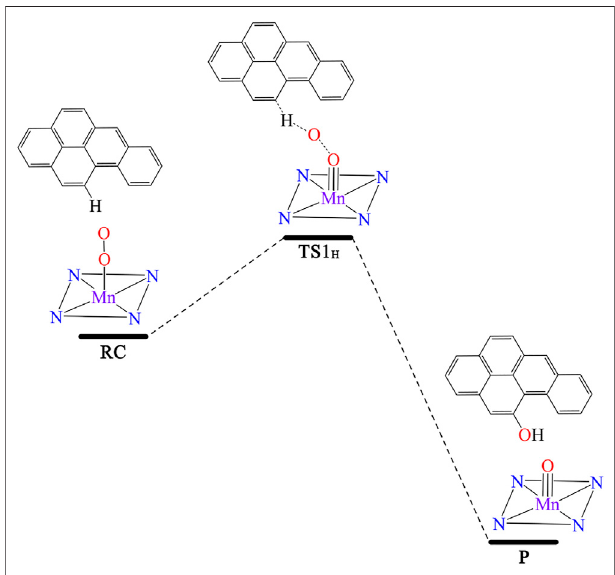
FIGURE 5 | The one-step reaction process converting BaP into 11- OH-BaP.